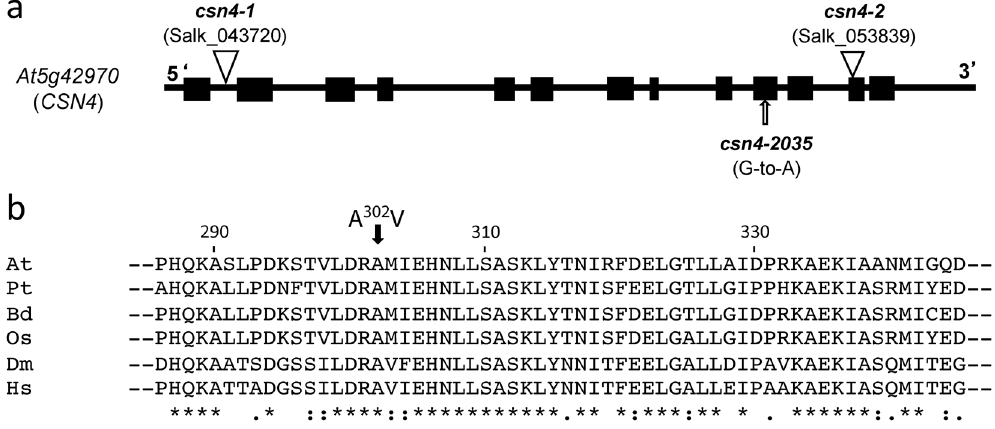
Figure 1. The csn4 alleles used in this study. (a) Structure of the Arabidopsis CSN4 subunit gene, with the position of the csn4-2035 point mutation and of the two T-DNA insertion lines. Exons are indicated by black boxes, introns by lines. (b) A comparison of a fragment from the Arabidopsis CSN4 protein with homologs from other organisms. The position of highly conserved Ala 302 , mutated in csn4-2035 , is highlighted. The position and nature of the amino acid substitution found in CSN4-2035 mutant protein is shown. Below, an alignment of CSN4 proteins from Arabidopsis thaliana (NP_199111.1; residues 286–345), Populus